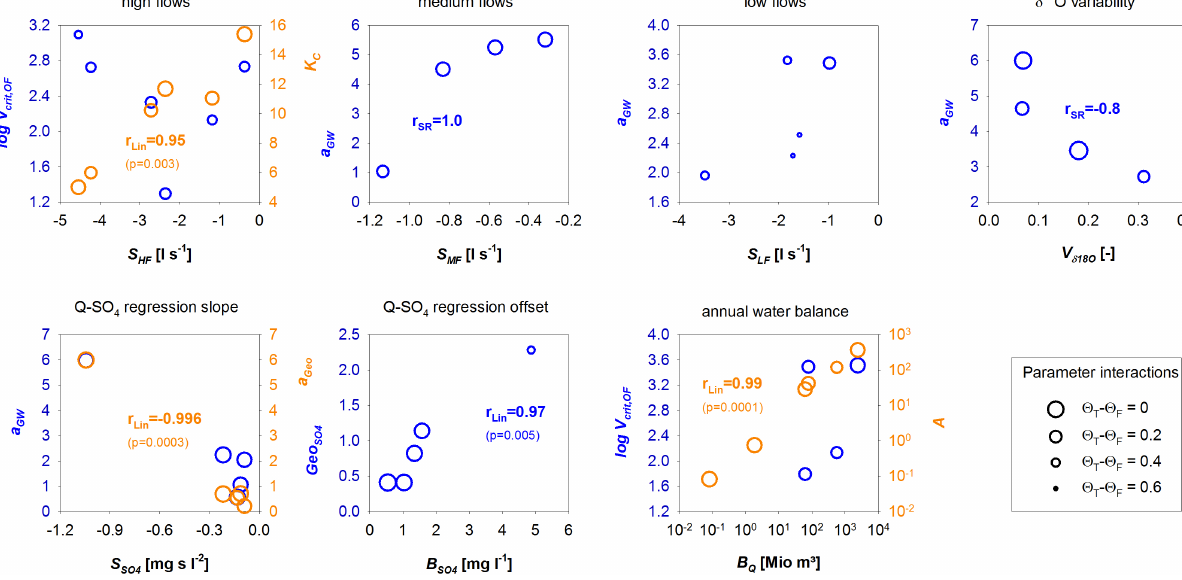
Fig. 5. Relationships between calibrated parameters with 2 F ≥ 0.1 and system signatures; dot sizes indicate parameter interactions 2 T − 2 F : the smaller the dot, the larger the interactions, the higher the uncertainty of the parameter location ( r Lin and r SR are linear correlation coefficient and the Spearman rank correlation coefficient, respectively; p values are only calculated for the linear